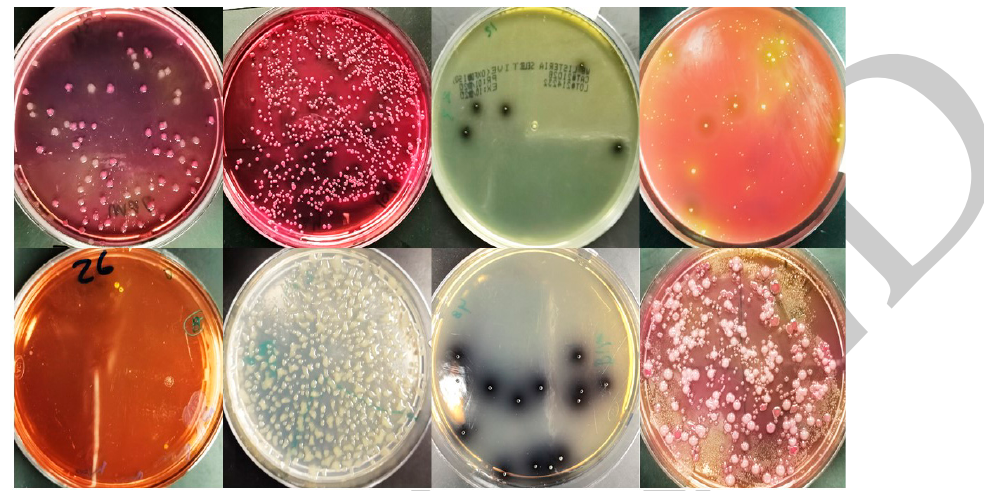
Figure 1. Single colonies were isolated from frozen and freshly prepared burger samples.